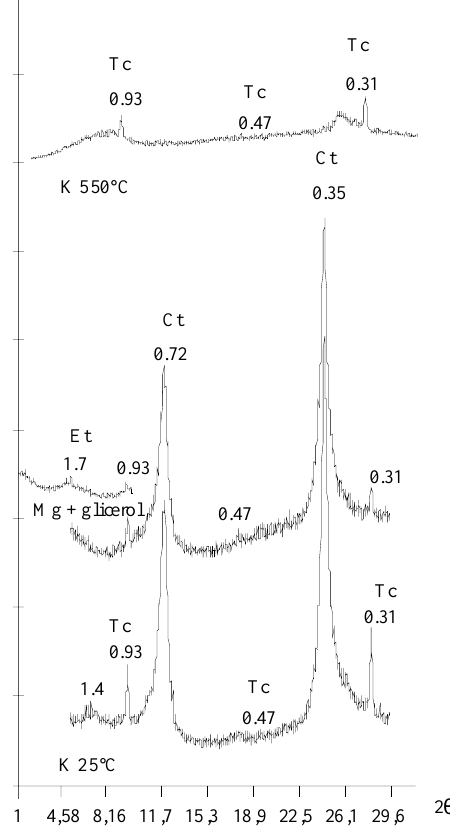
Figura 7. Difratogramas de raios-X da amostra 2C (Perfil 2 – PVe) com os diversos tratamentos. Espaçamento d em nm (Vh = vermiculita com hidróxi entrecamadas, Ct = caulinita, It = illita).